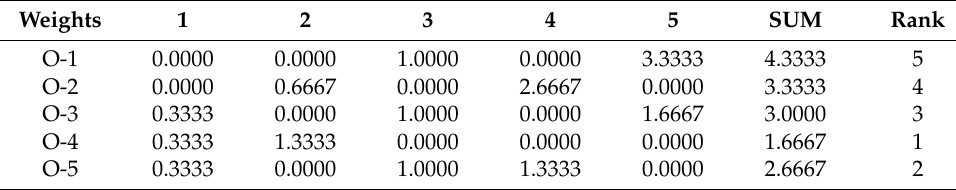
Table 18. Final ranks of operations using degree of membership